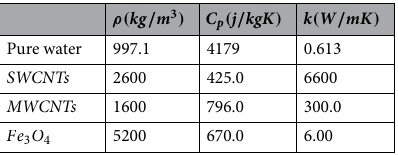
Table 1. The numerical properties of water, CNTs and Fe 3 O 4 .